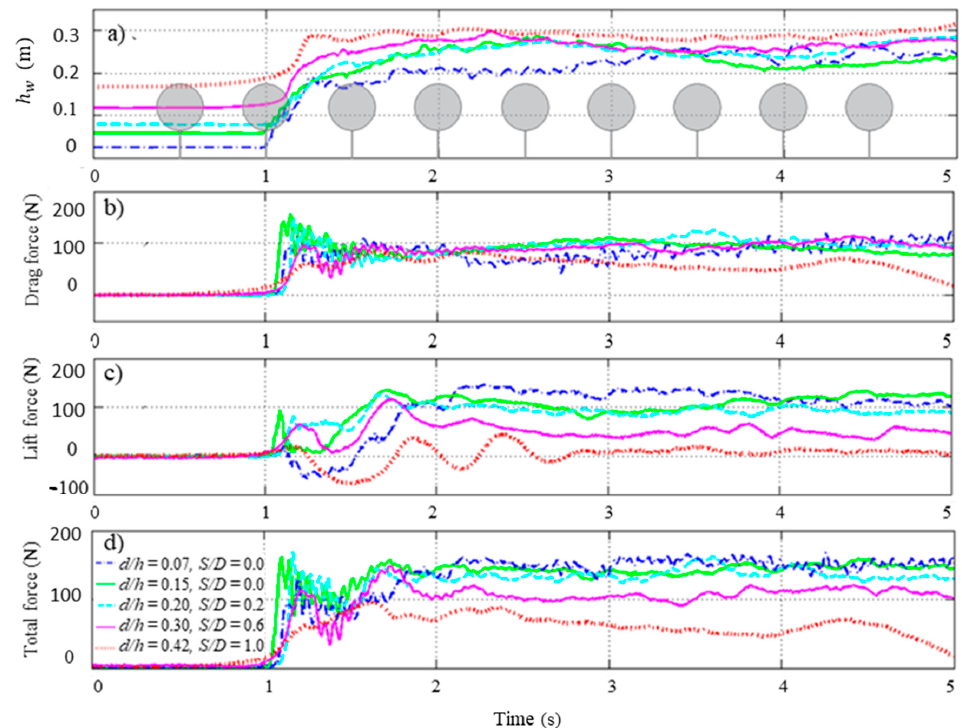
Figure 9. Time-history of the water level and force component measurements at WG3 for the wet bed condition, different d/h ratios ( d/h = 0.075, 0.15, 0.2, 0.3, and 0.42), and e/D = 0.6: ( a ) water level, ( b ) drag force time-history, ( c ) lift force time-history, and ( d ) total